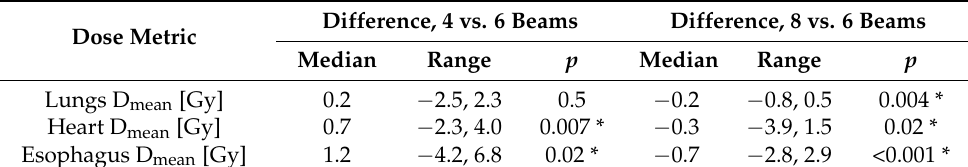
Table 6. Median differences in D mean with range for OARs in 4- and 8-beam iCE plans compared to 6-beam iCE plans, all with optimized beam angles. p -values for comparison with 6-beam plans are given, and significant differences are marked with *. Dose Metric